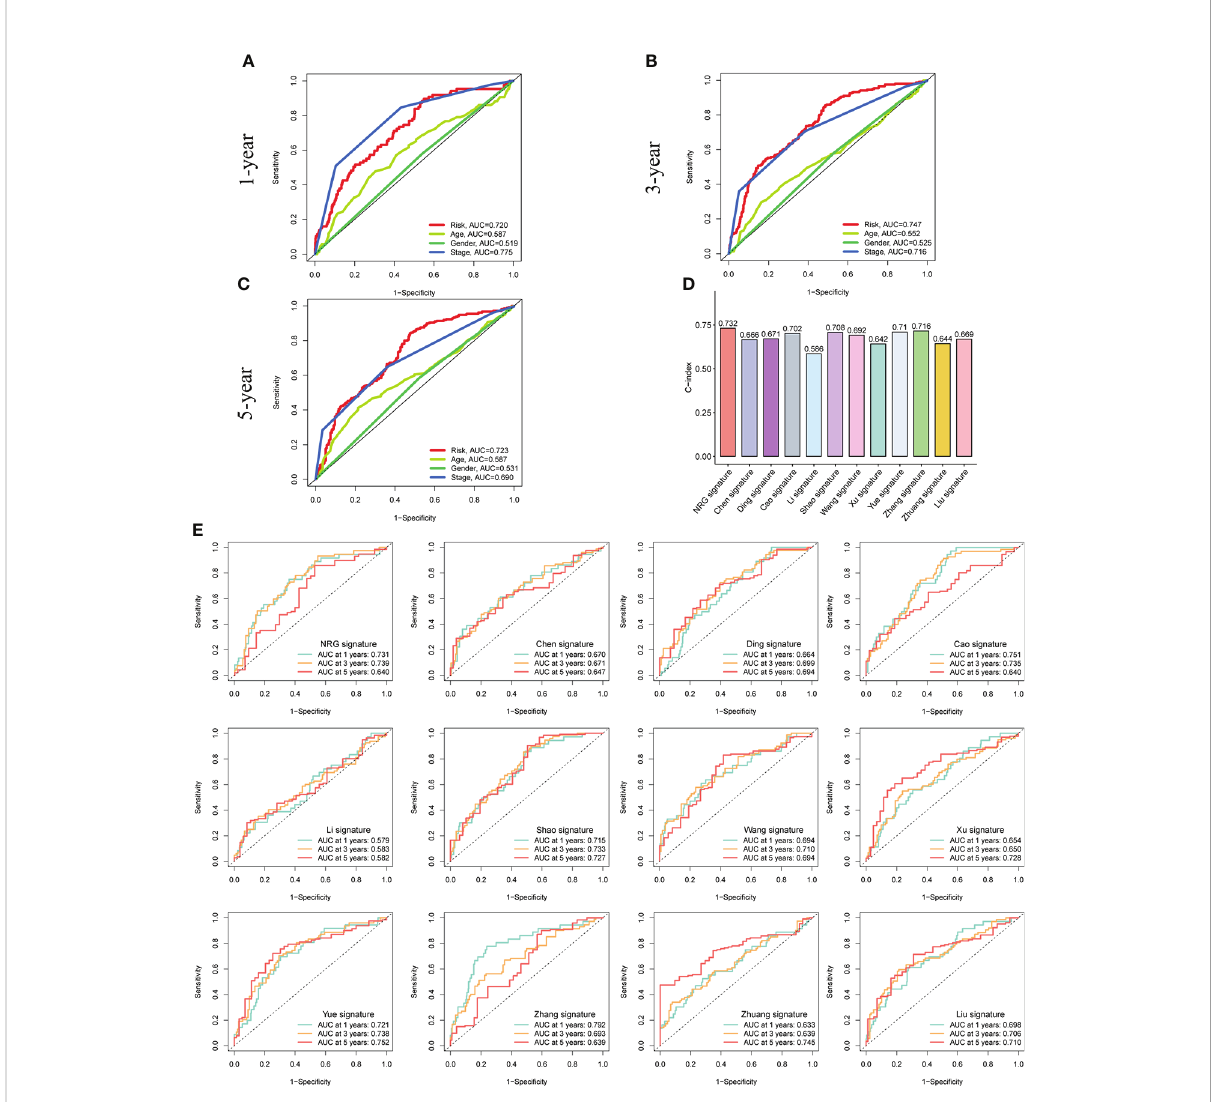
FIGURE 6 Veri fi cation and comparison of the signature. (A-C) The comparison of 1-, 3-, and 5-year ROC curves of the signature and other clinical characteristics in the whole cohort. (D) C-index of various types of prediction models constructed for CRC. (E) ROC curves to compare the prediction performance of various signatures of 1-, 3-, and 5-year survival in the TCGA-COAD